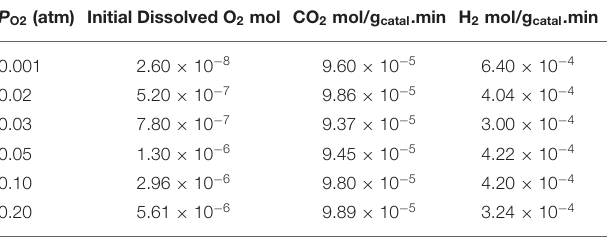
TABLE 1 | H 2 and CO 2 production rates and initial concentrations of dissolved O 2